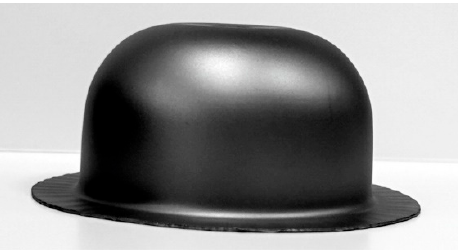
Figure 9. Grade 2 drawn part formed with lubricant No. 2.